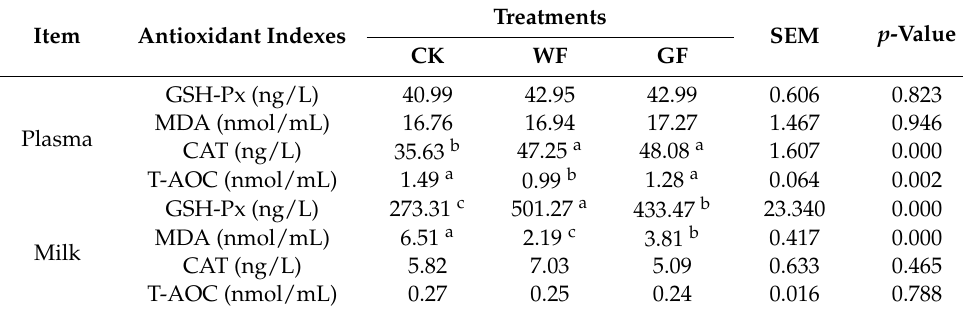
Table 6. Antioxidant indexes in plasma and